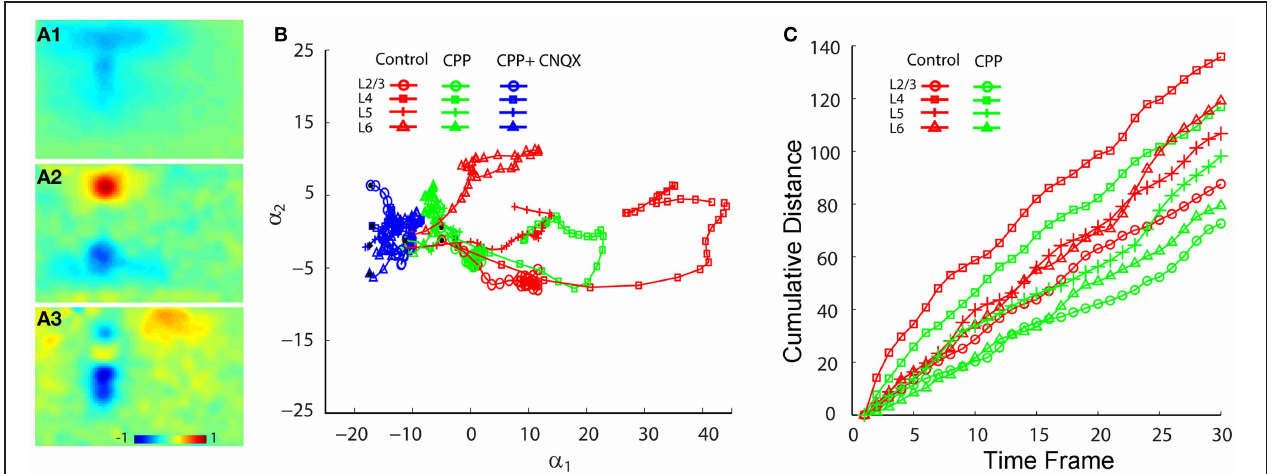
FIGURE 7 | PCA comparison of projection trajectories of photostimulation-evoked VSD responses in normal ACSF, in the presence of CPP and with the co-application of CPP and CNQX. The PCA are based on the image data sets presented in Figure 6 . (A1–A3) Show the first three principal spatial modes (shown as images) derived from the PCA decomposition of the combined VSD image sequence ( N = 12 files) from the four stimulation sites (layers 2/3, 4, 5, and 6) in